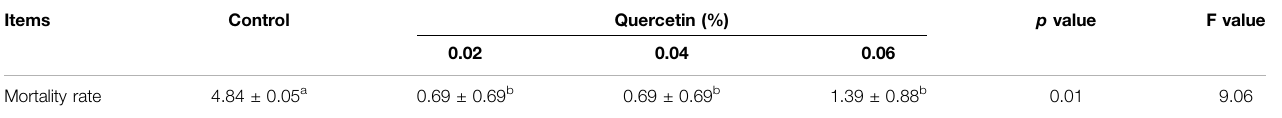
TABLE 7 | Effect of quercetin on the mortality rate of AA